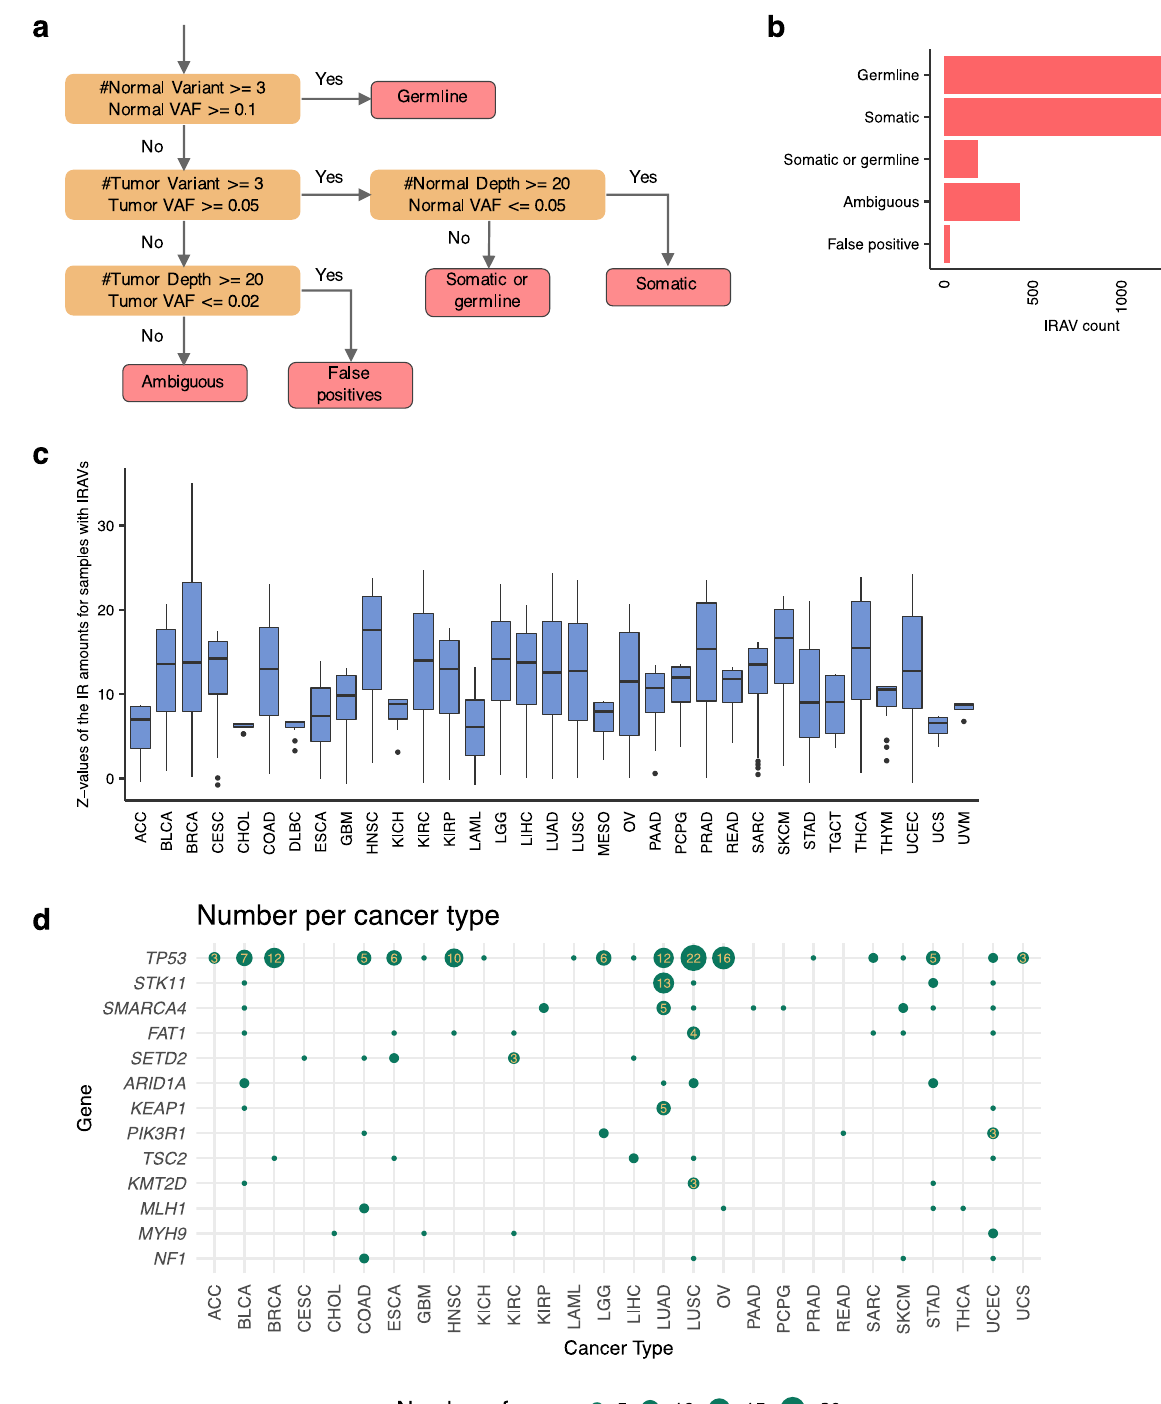
Fig. 2 | Assessment of the IRAVNet approach using TCGA transcriptome and exome sequencing data. a The fl owchart showing the classi fi cation of genome level mutation status for IRAVs. Here, according to sequencing depths, the variant counts(thenumbersofintronretentionreads),andvariantallelefrequencies(VAF, the ratios of intron retention reads to the total number of sequencing reads cov- ering the corresponding exon-intron boundaries), the status are classi fi ed into “ germline, ” “ somatic, ” “ somatic or germline, ” “ ambiguous ” , and “ false positive. ” b The number of IRAVs categorized by the inferred mutation status for the iden- ti fi ed IRAVs determined by the above procedure. c The boxplot showing how the intron retention is speci fi c to the samples with the IRAVs. The ends of the boxes indicate lower and upper quartiles; center line, median; whiskers, maximum and